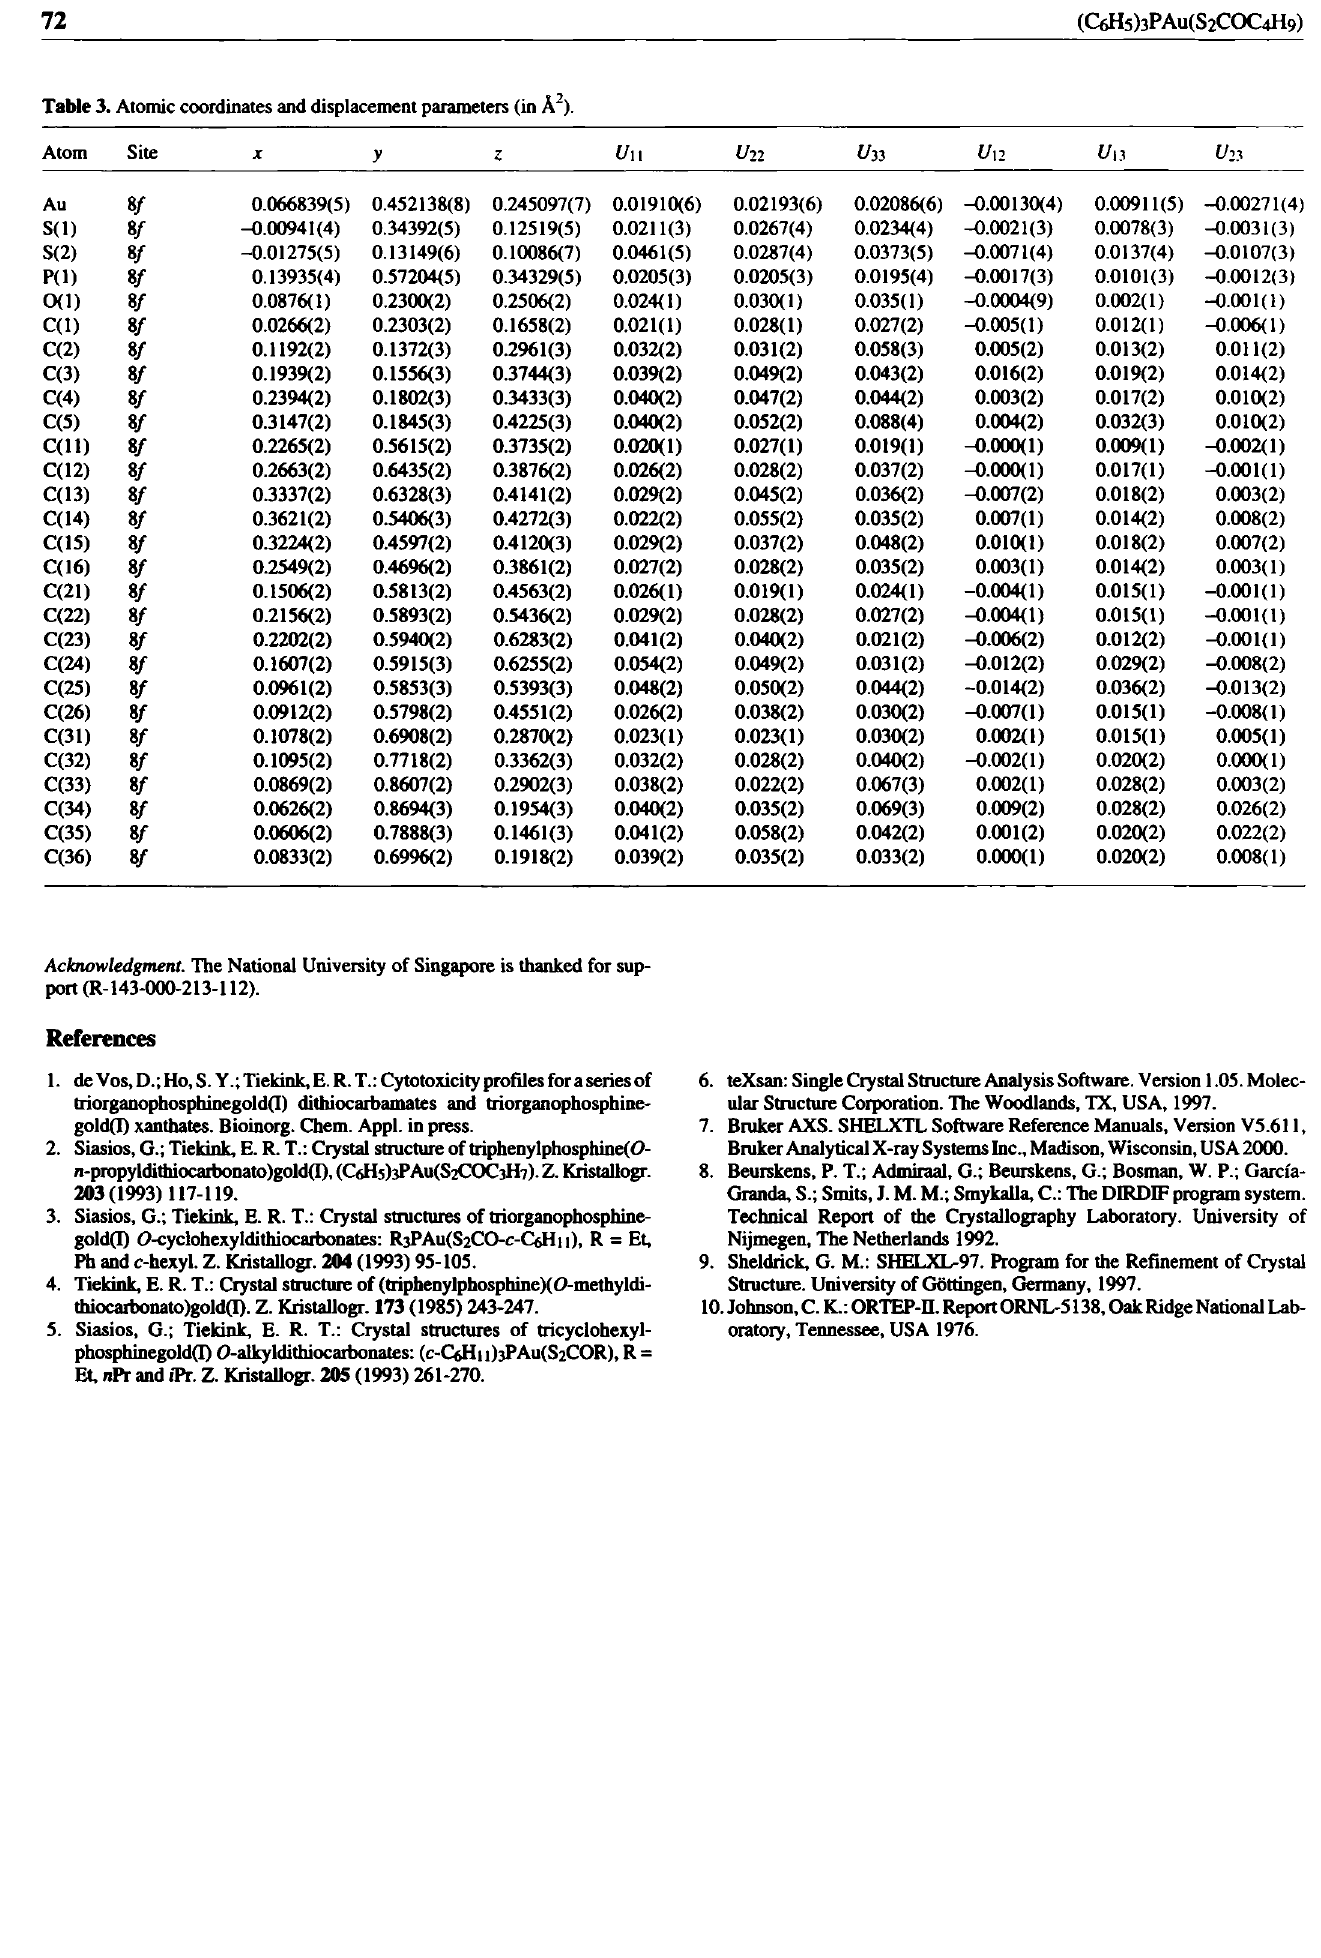
Table 3. Atomic coordinates and displacement parameters (in Ä 2